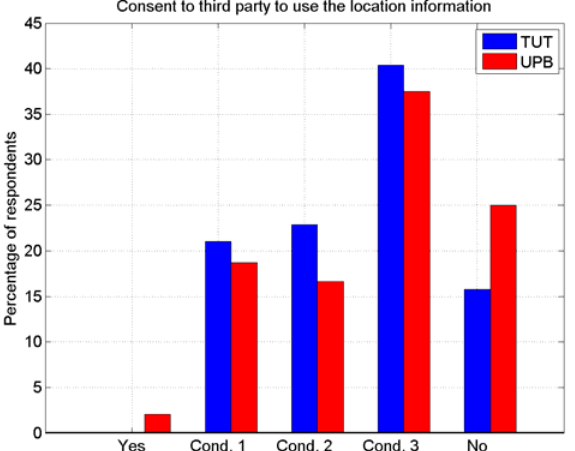
Figure 12. Consent to third party to use location information, according to pre-defined user